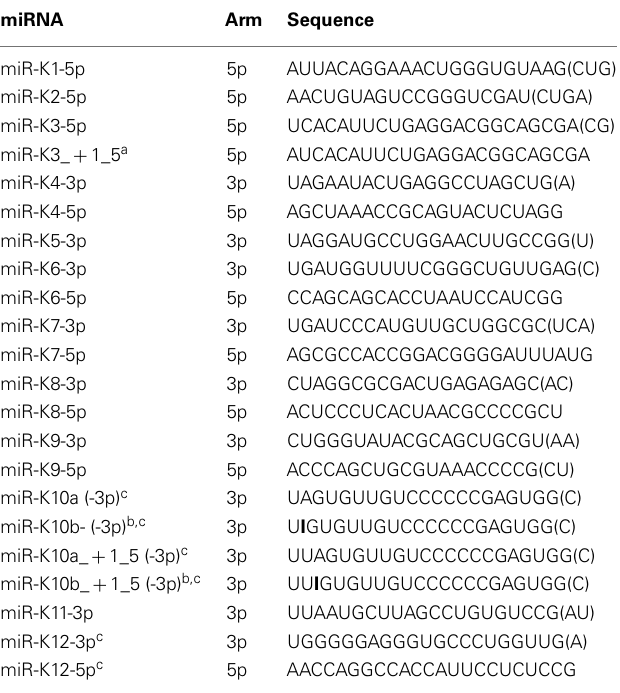
Table 1 | Sequences of the KSHV miRNAs. miRNA Arm Sequence